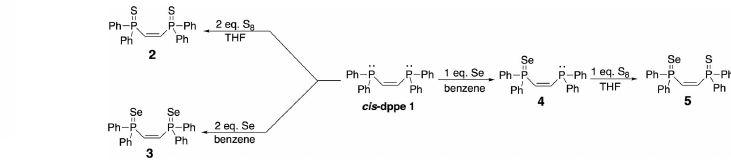
Figure 1 A generalized reaction scheme to prepare the compounds studied in this